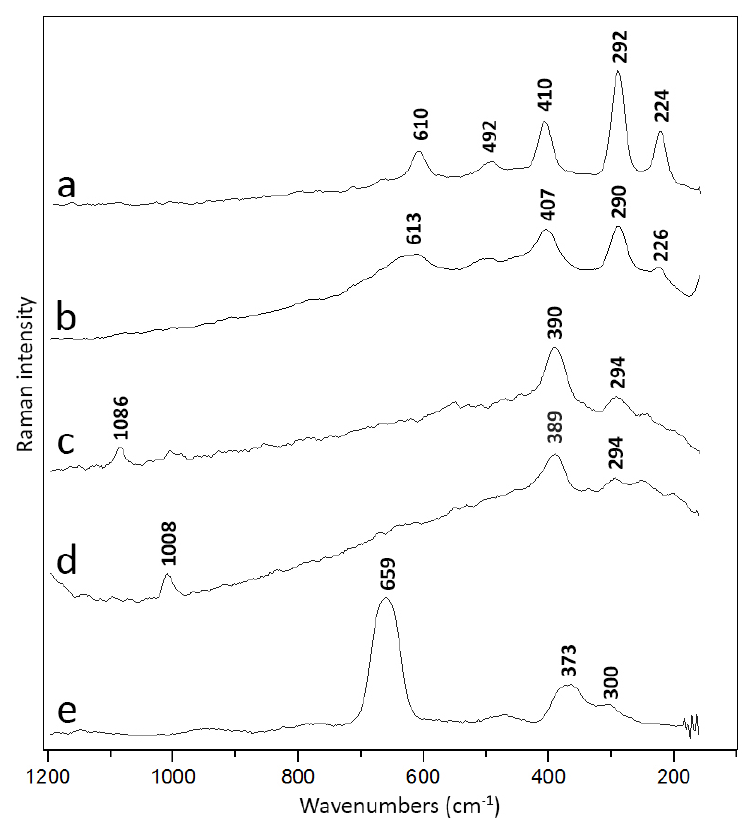
Figure 2. Raman spectra collected on: ( a ) sample PK11273; ( b ) sample PK40490; ( c ) sample PK40280; ( d ) sample PK40260; ( e ) sample PK40623.